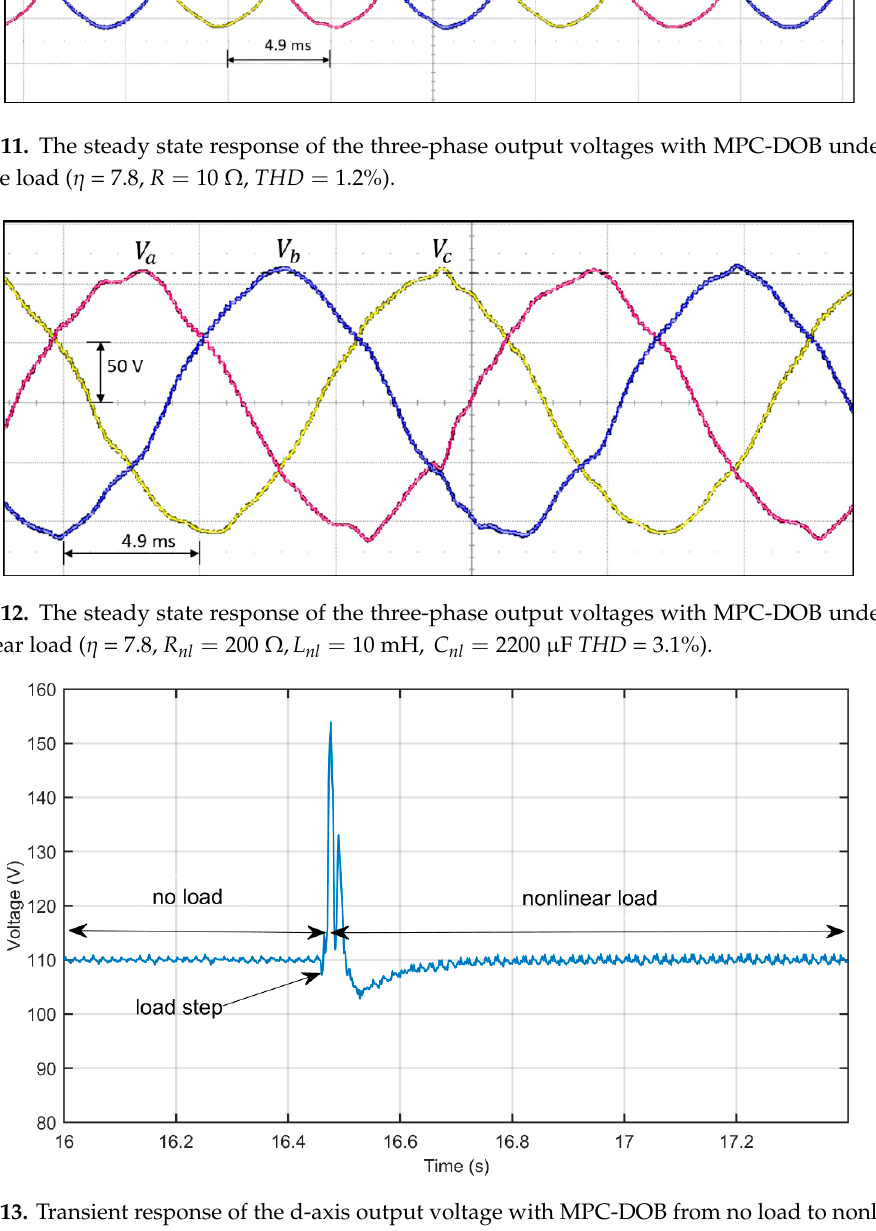
Figure 13. Transient response of the d-axis output voltage with MPC-DOB from no load to nonlinear load step ( THD = 3.1%, η = 7.8).